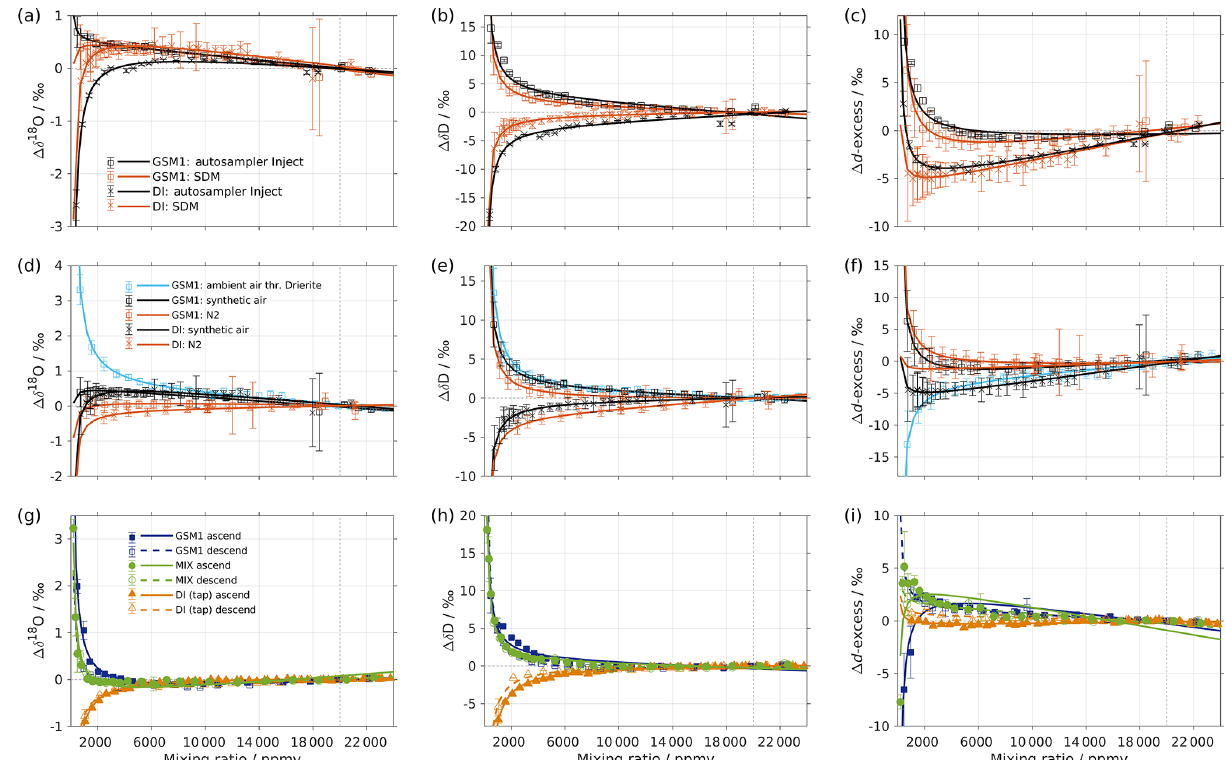
Figure A1. (a–c) Comparison of the isotope composition–mixing ratio dependency of uncalibrated measurements with two different char- acterisation methods for (a) δ 18 O, (b) δ D, and (c) d -excess. The measurements are carried out on instrument HIDS2254 (Picarro L2130-i), either with discrete injections using an autosampler (black symbols; experiment 2) or with continuous vapour streaming by using the SDM (red symbols; experiment 6) and using synthetic air as the carrier gas for both. The symbol and error bar represents the mean and standard deviation of the mean for the last three of a total of four injections for the measurement via the autosampler, and the mean and standard deviation of the last 2–5min of a 20–30min long sequence for the measurement via SDM. The solid line represents the fit using the same function as in Fig. 1. Panels (d–f) are the same as (a–c) but compare different carrier gases. The measurements are carried out on instrument HIDS2254 (Picarro L2130-i), with continuous vapour streaming via SDM (experiments 6–8). Two standard waters (GSM1 and DI) are tested with synthetic air (black symbol) and N 2 (orange symbol). The standard water GSM1 is also tested with ambient air that is dried through Drierite (blue symbol). Panels (g–i) display the mixing ratio dependency of GSM1 (dark blue symbol), MIX (green symbol), and TAP water (orange symbol) with ascending (closed symbol) and descending (open symbol) mixing ratio sequences. Solid curves represent the fits for ascending mixing ratio sequences, and dashed curves represent the fits for descending mixing ratio sequences. All the measurements are uncalibrated and carried out with discrete injections using an autosampler with N 2 as the carrier gas. The measurements for TAP and MIX are carried out on instrument HKDS2038 (Picarro L2140-i; experiments 9 and 11). The measurements for GSM1 are carried out on instrument HKDS2039 (Picarro L2140-i), and one outlier at around 500ppmv has been excluded (experiment